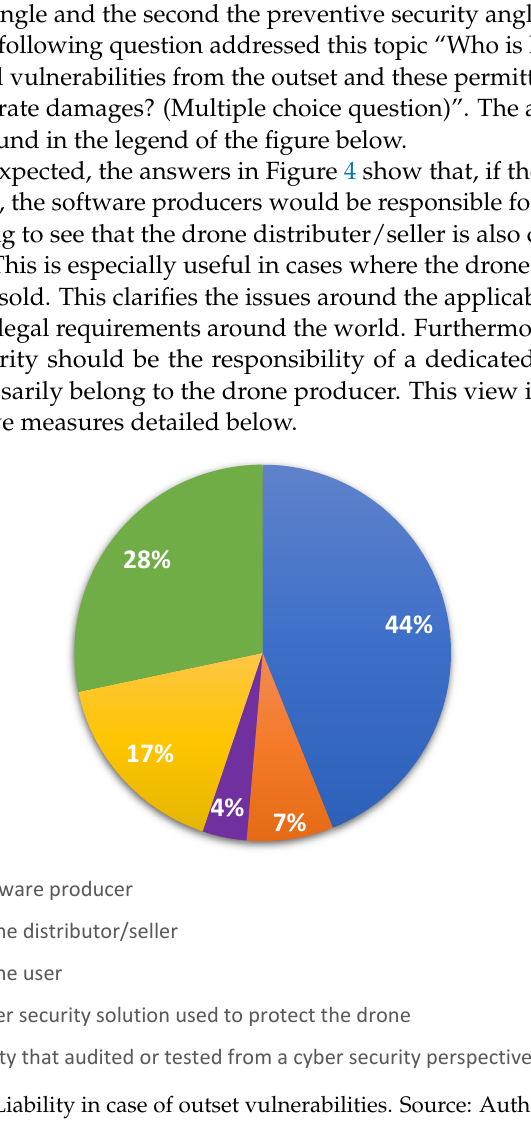
Figure 4. Liability in case of outset vulnerabilities. Source: Author’s processing.